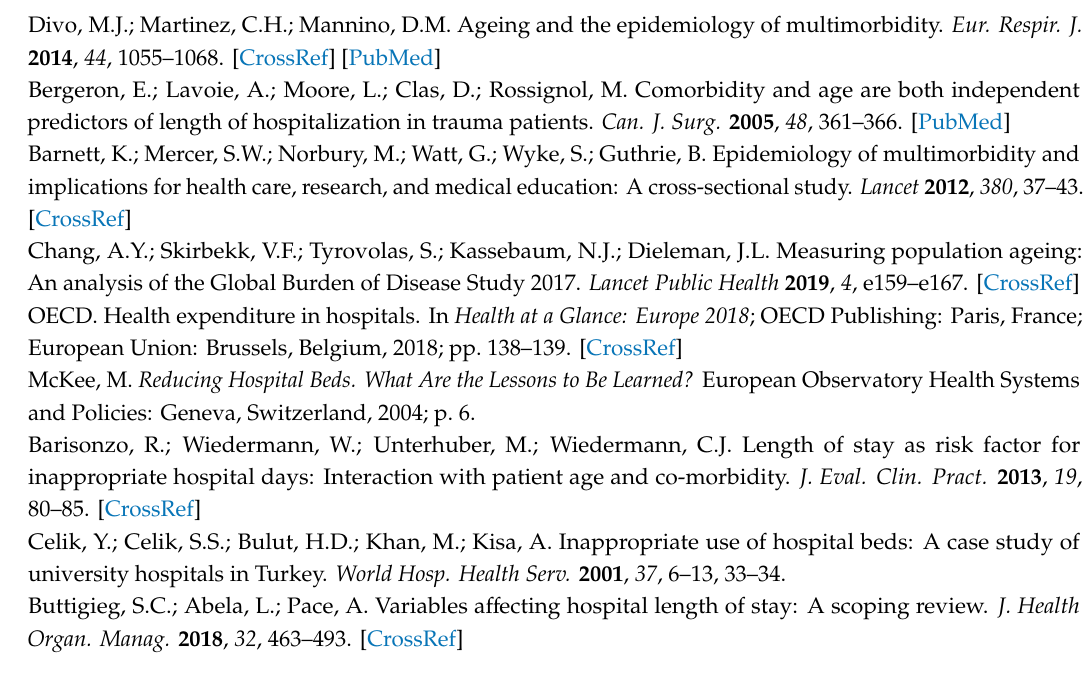
Table S1: Diagnostic related group (DRG) Codes for di ff erent specialties; Table S2: Uni-variate associations with prolonged hospital length of stay for patients hospitalized over two years in Victoria, Australia; Table S3: Associations with prolonged hospitalization ( ≥ 14 days) for patients hospitalized over two years in Victoria, Australia who were discharged alive; Table S4: Uni-variate associations with in-hospital mortality for patients hospitalized over two years in Victoria, Australia; Table S5: Nature and destination of discharge among people who survived in hospital for patients hospitalized over two years in Victoria, Australia; Table S6: Independent associations with hospital discharge to home for patients hospitalized over two years in Victoria, Australia; Table S7: Summary of literature describing epidemiology of prolonged hospitalizations 2015 to